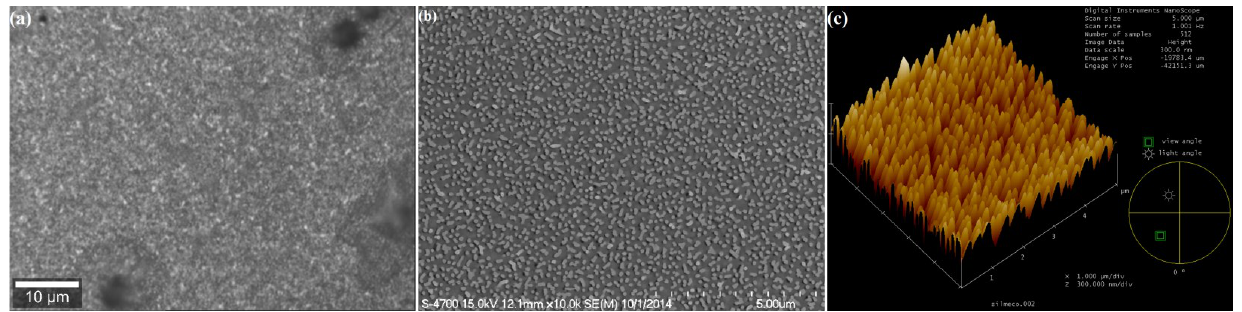
Figure 4. ( a ) Ag functionalised substrate, p53 protein on antibody-ATP-Ag surface. Reflected light image captured using 100× air objective lens. Bright spots show layer of Ag nanoparticles on the surface of the substrate; ( b ) Top view SEM image showing nanopillars on substrate surface, scale bar on bottom indicates 5 micron; ( c ) AFM image of Silmeco substrate showing surface